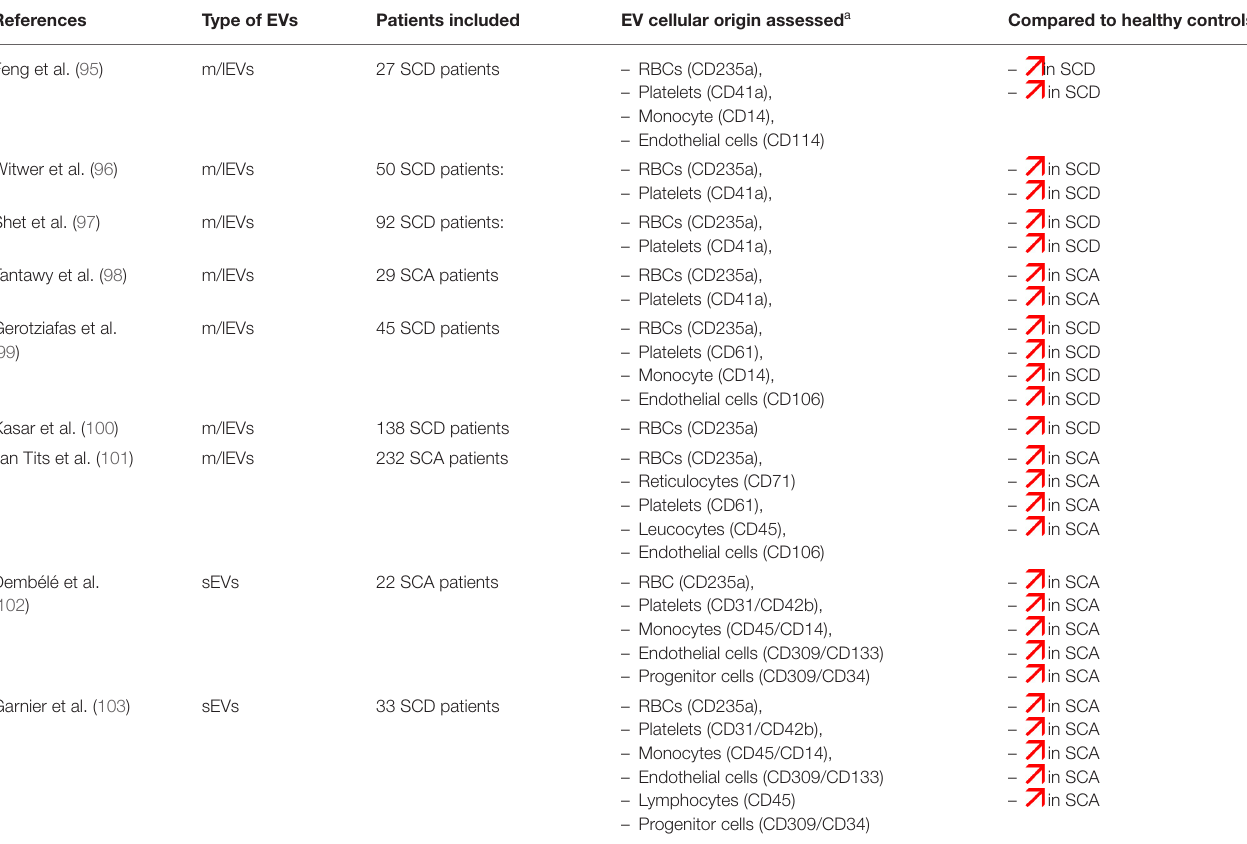
TABLE 2 | Comparison of blood cell type-derived EVs determined by flow cytometry between SCD patients and healthy